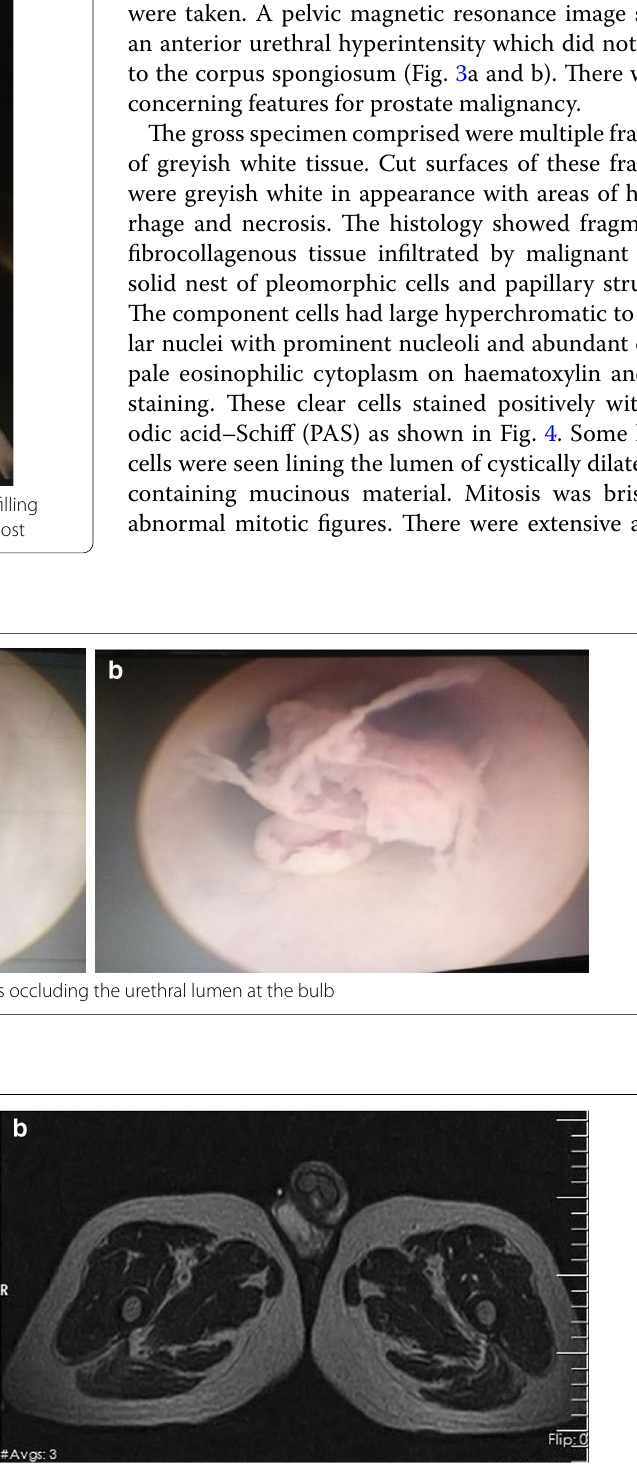
Fig. 3 MRI showing a predominantly hyperdense lesion within the penile urethra in a coronal view b Axial